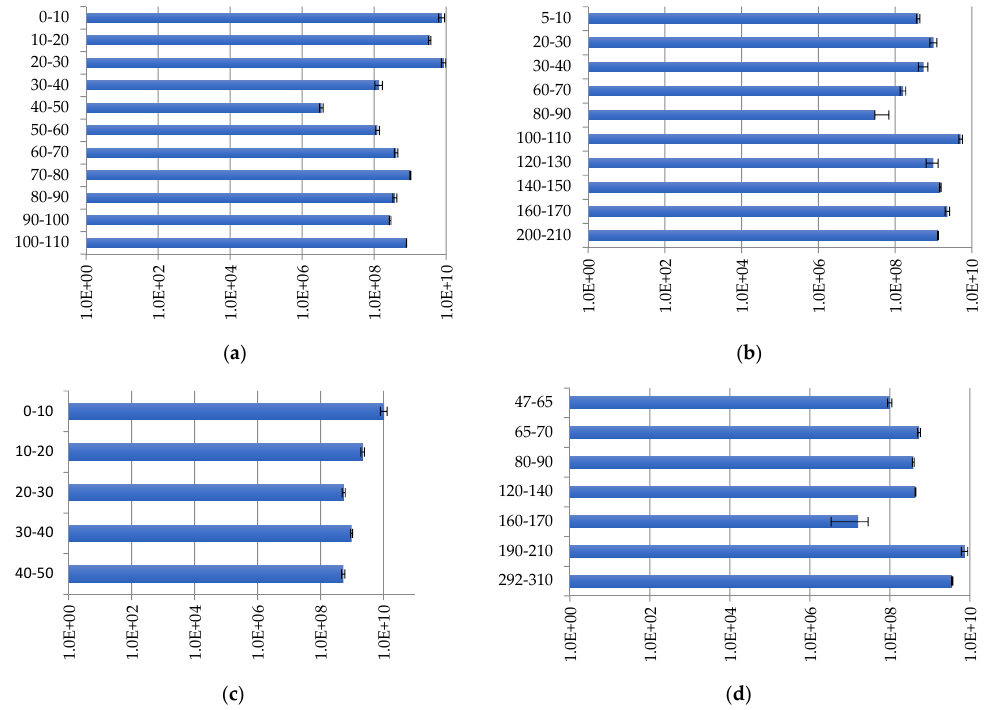
Figure 4. Archaeal distribution (copies/g of soil) in peat strata: ( a ) Inta 1; ( b ) Kolva; ( c ) Inta 11; and ( d ) Voda-Ty. The profile distribution of archaea in sites Kolva, Inta 11, and Voda-Ty is similar to the bacterial distribution in the peatlands. At site Kolva, the number of archaeal genes decreases, reaching a minimum value of 2.9 × 10 7 copies/g of soil at 80 – 90 cm, which then increases sharply by two orders of magnitude, 5.1 × 10 9 copies/g of soil, at a depth of 100 – 110 cm (Figure 4b). The maximum number of archaeal 16S rRNA genes at site Inta 11 (Figure 4c) is detected in the 0 – 10 cm layer, amounting to 1 × 10 10 copies/g of soil, and the minimum is at a depth of 40 – 50 cm, amounting to 5.3 × 10 8 copies/g of soil. At site Voda- Ty, the minimum number of archaeal ribosomal operons is found in the 160 – 170 cm layer, amounting to 1.6 × 10 7 copies/g of soil, and the maximum number is found at a depth of 190 – 210 cm, amounting to 7.5 × 10 9 copies/g of soil (Figure 4d).